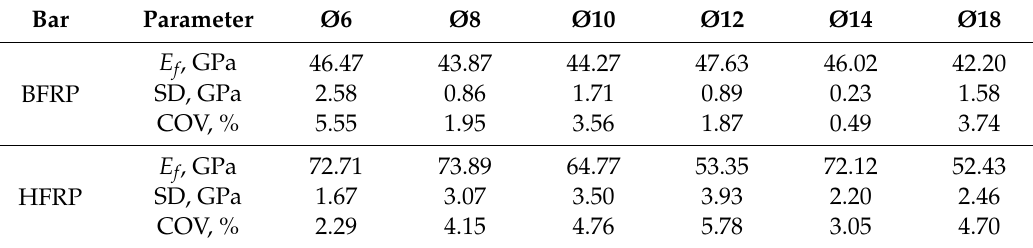
Table 3. Modulus of elasticity of FRP bars.